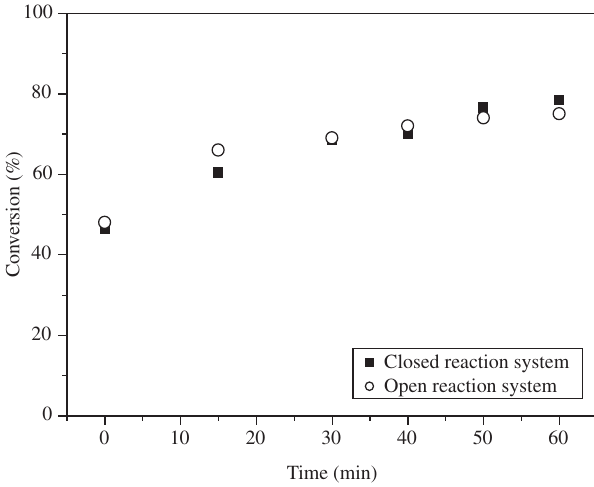
Figure 5. Silica conversion as function of reaction time for different tempera- O/SiO ratio = 22; NaOH/SiO tures (H 2 2 2